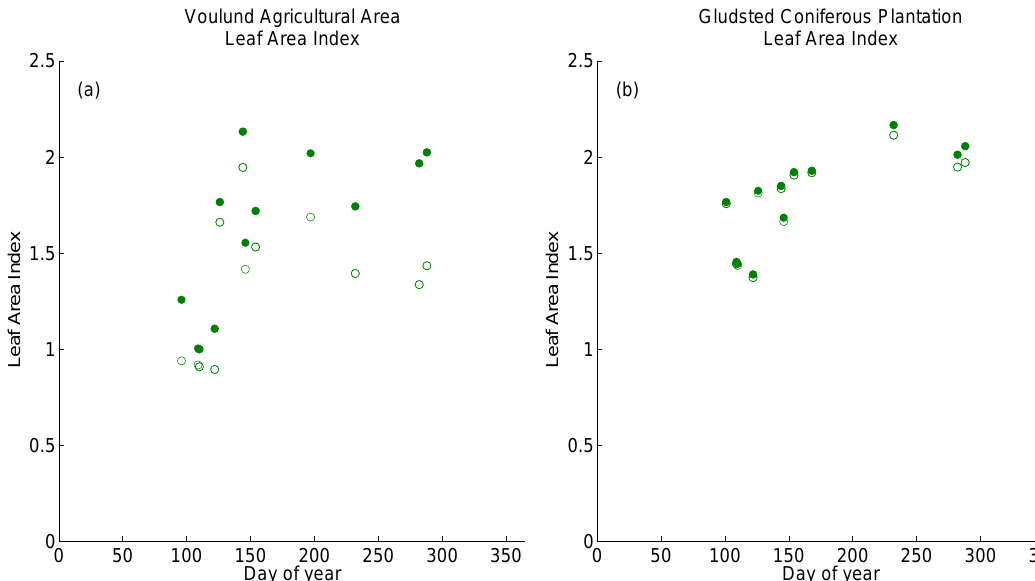
Figure 2. Temporal distribution of leaf area index (LAI) estimates at VOU and GLU sites. The x axis indicates the day of year of the estimate, while the y axis shows the mean Landsat-scale LAI within the flux tower footprint. Landsat LAI estimates were based on MODIS LAI estimates. Empty circles represent green LAI derived directly from MODIS estimates, while full circles represent total LAI, used as input to the model and derived by (in some cases) dividing green LAI by fraction of vegetation that is green. For details see sections 2.2.